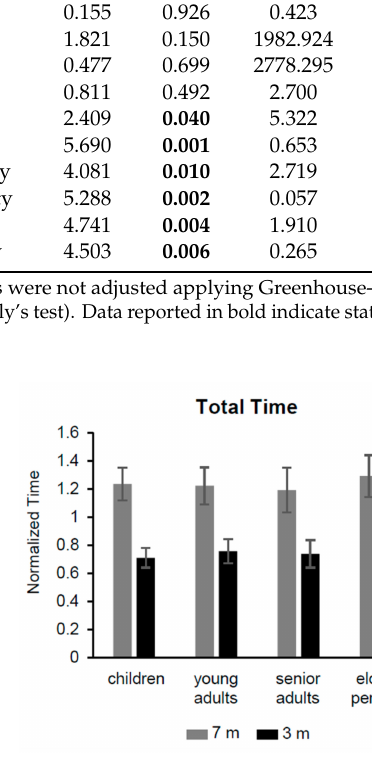
Figure 2. Total time of iTUG test. Non-dimensional normalized time of the four groups to complete the iTUG test over 7 and 3